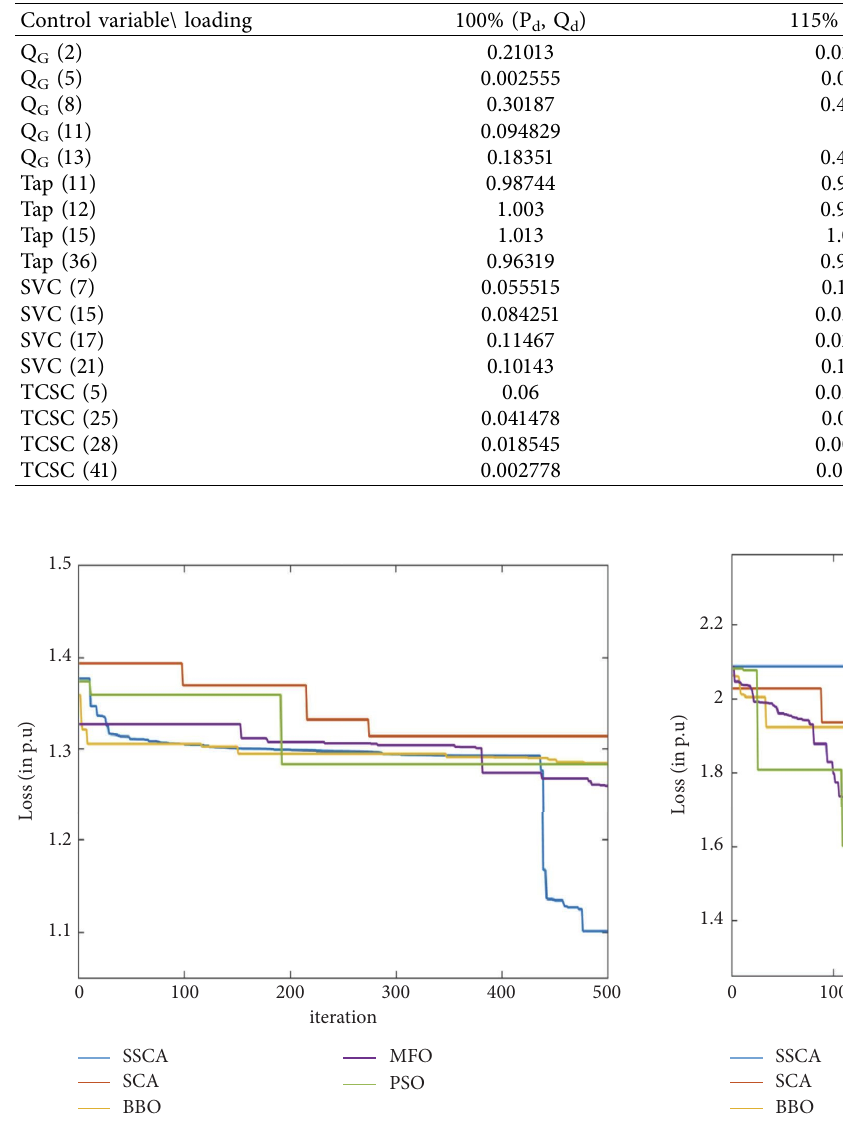
Figure 11: Loss variation in the IEEE-118 bus system at 115%